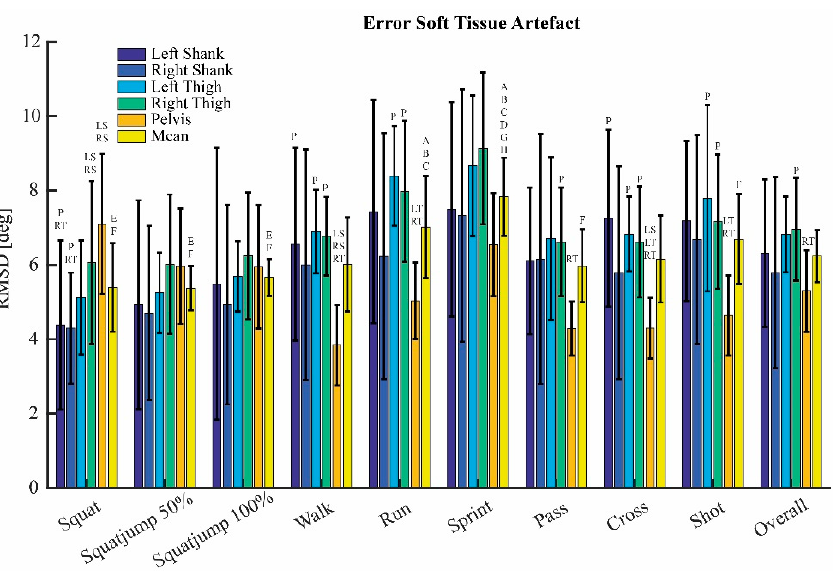
Figure A1. Error caused by the soft tissue artefact. Mean root-mean-square differences (RMSD) and standard deviations for all body segments and all trials. Significant differences within each trial between body segments are displayed by letters above the bar, LS, RS, LT, RT, and P mean a significant difference with the left shank, right shank, left thigh, right thigh, and pelvis, respectively. Significant differences between trails are displayed with a letter above the mean bar. A = squat, B = squat jump 50%, C = squat jump 100%, D = walk, E = run, F = sprint, G = pass, H = cross and I =